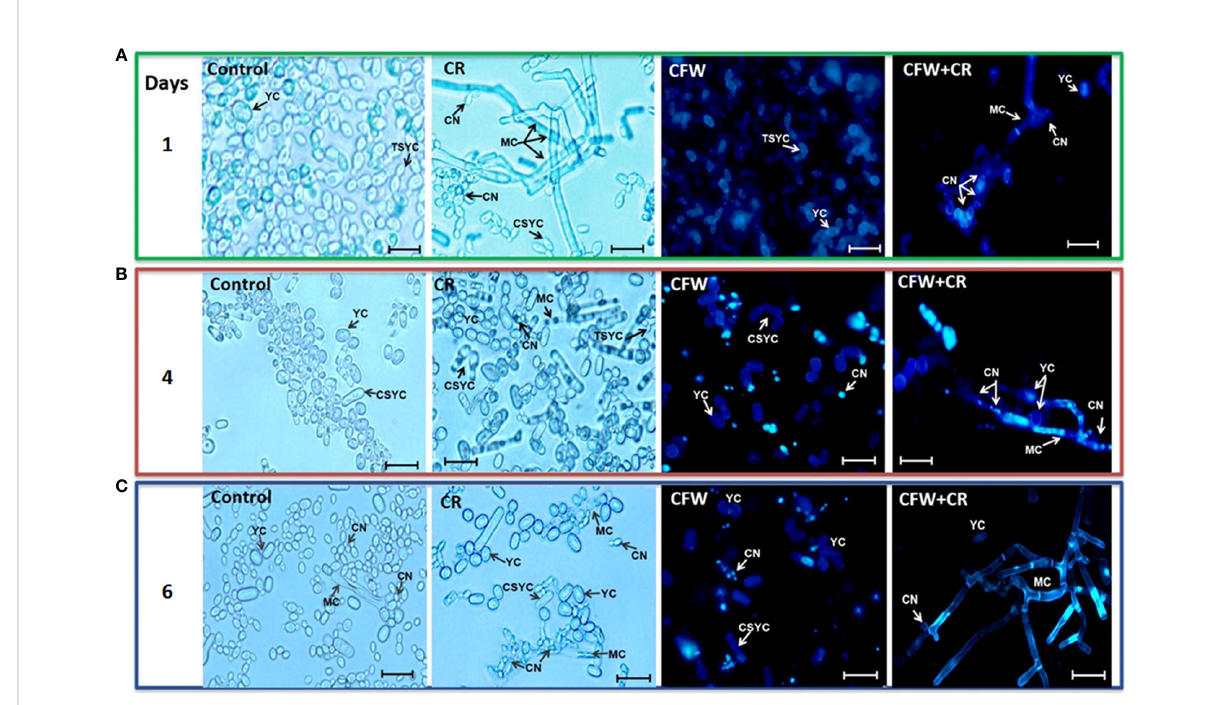
FIGURE 7 Yeast morphology of S. globosa in response to CR and CFW. The yeast morphotype was propagated in the absence or presence of CR o CFW and after the indicated times, cultures were inspected by bright fi eld and epi fl uorescence microscopies to register the cell morphology. CN, conidia; YC, yeast cell; MC, mycelial cell; TSYC, tear-shaped yeast cell; CSYC, cigar-shaped yeast cell. Bar, 20 m m. Reproduced from Ortiz- Ramirez et al., 2021 with permission from Springer Nature, License Number 5315470121400 (May 24,